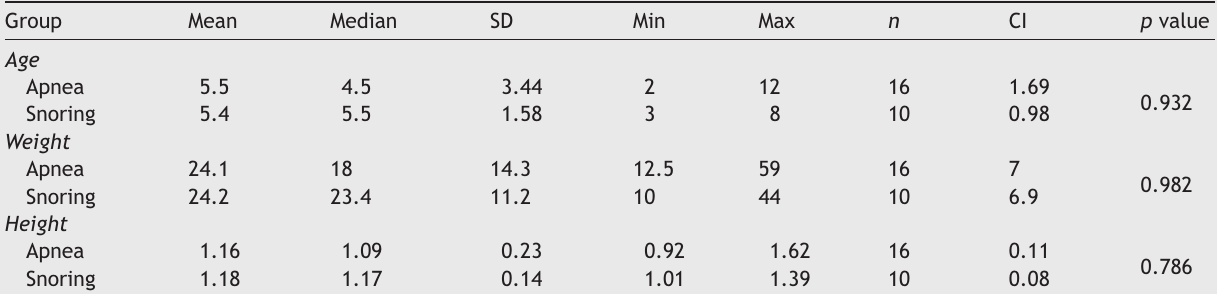
Comparison between apnea and snoring groups regarding age, weight and